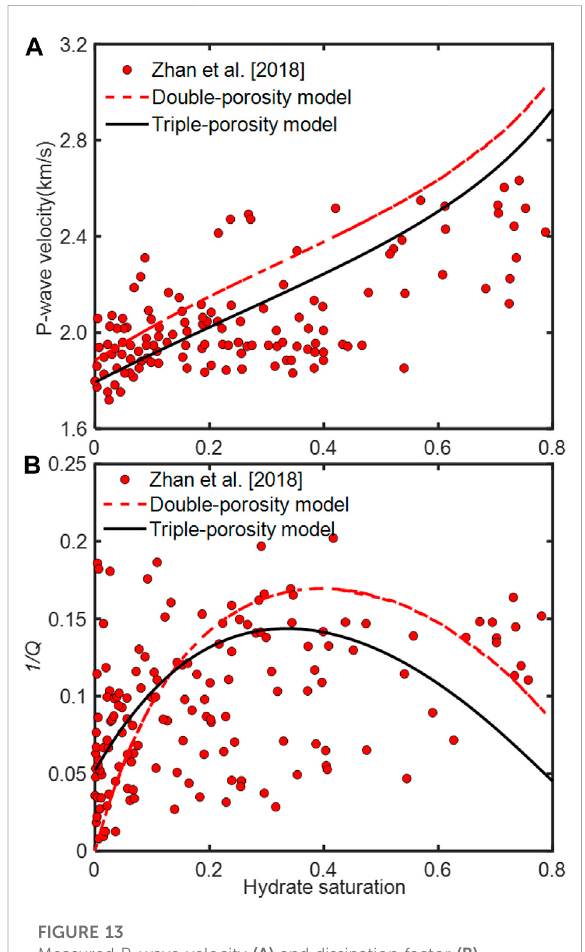
Measured P-wave velocity (A) and dissipation factor (B) (symbols) compared to the results of the double- and triple- porosity